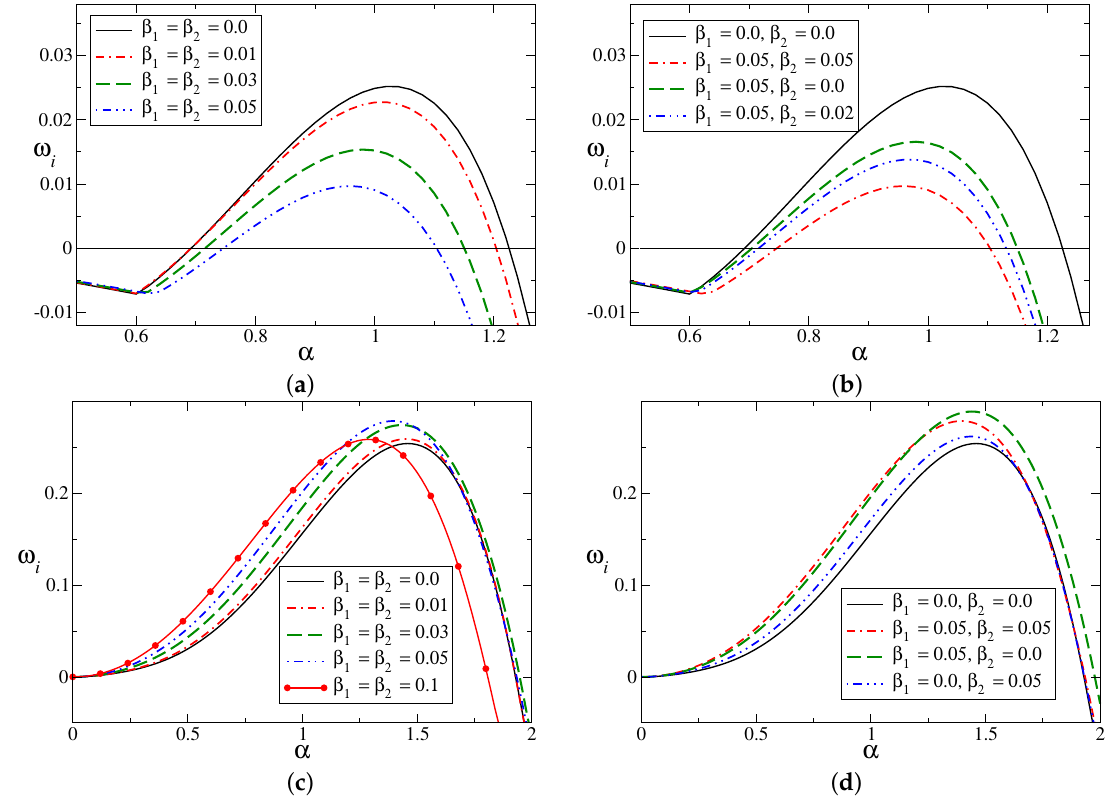
Figure 5. Growth rate ( ω i ) curves for Re = 4000: ( a , b ) for σ 1 = 0.0, σ 2 = 0.2; ( c , d ) for σ 1 = − 1.5, σ 2 = 0.2. ( a , c ) Symmetric slip ( β 1 = β 2 ), and ( b , d ) non-symmetric slip ( β 1 (cid:54) = β 2 ).